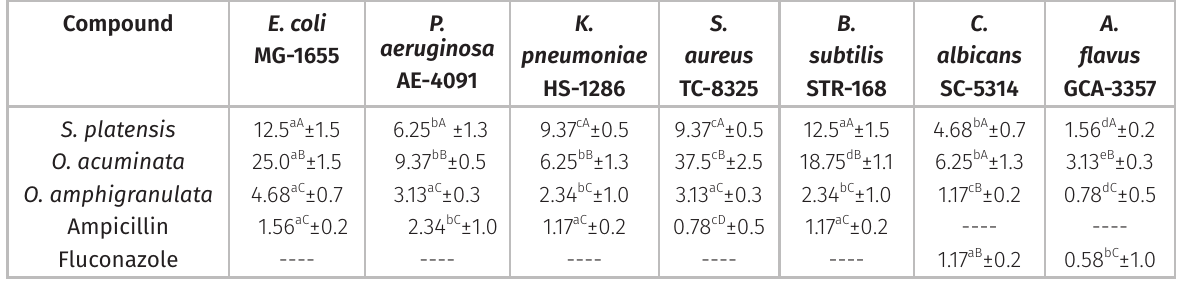
Table II. The minimum inhibition concentration (MIC µg/ml) of cyanobacterial methanolic extracts against different tested pathogens.